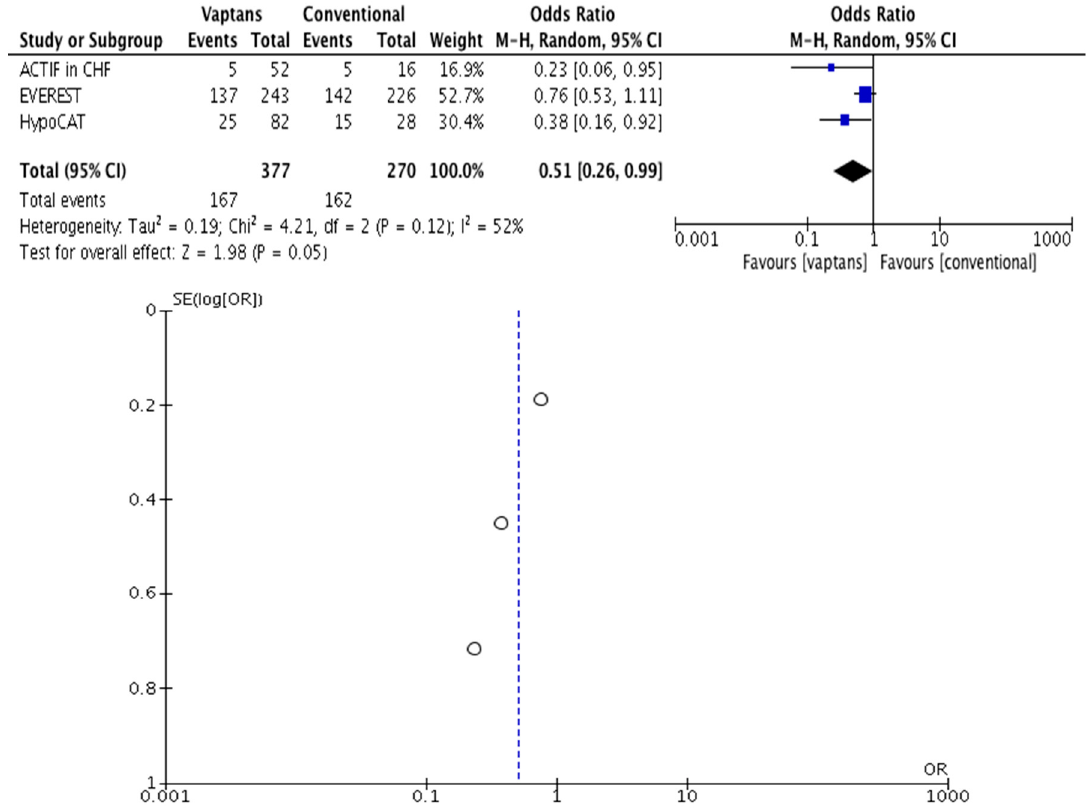
Figure 3. The effect of correction of hyponatremia on clinical outcomes in worsening HF and cirrhotic ascites.